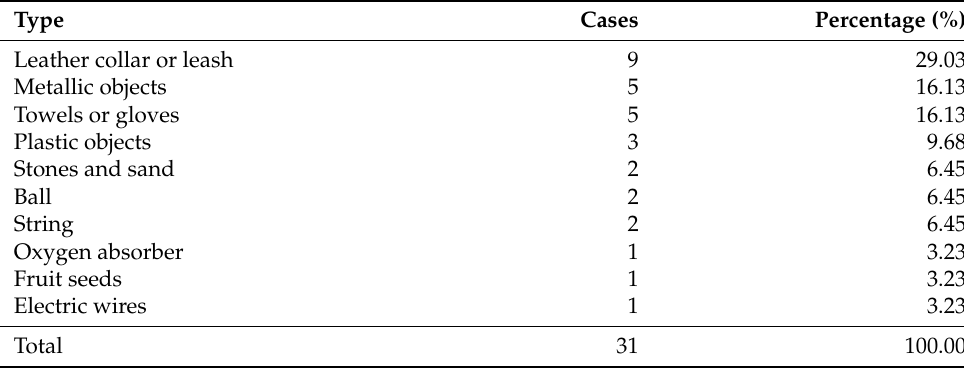
Table 9. Types of foreign objects.